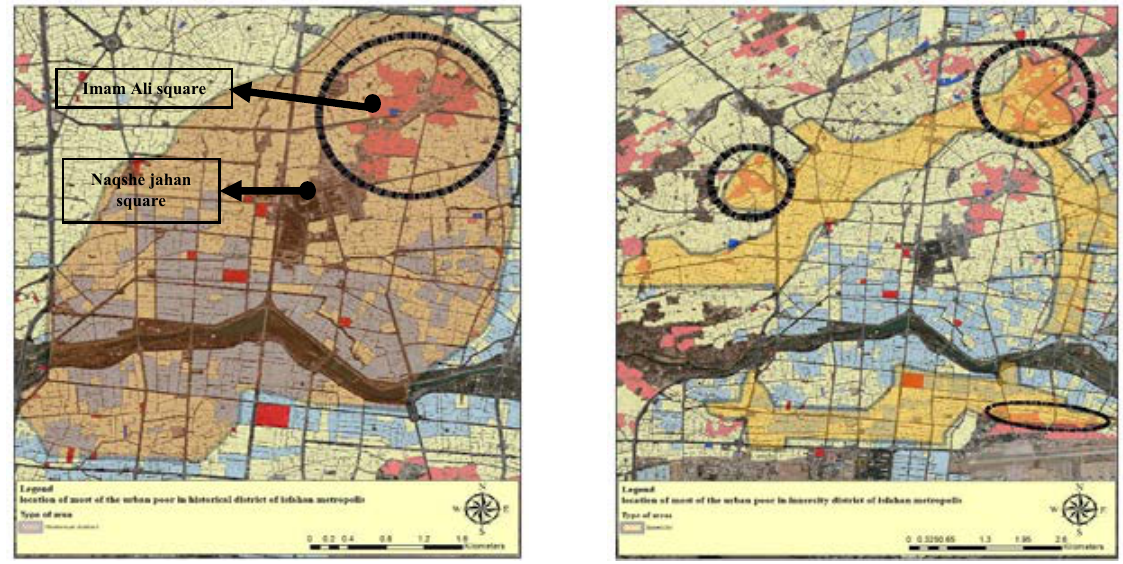
Fig. 10: The spatial concentrations of urban poor (UPRDS) poor in historical district (a) and inner city area (b)